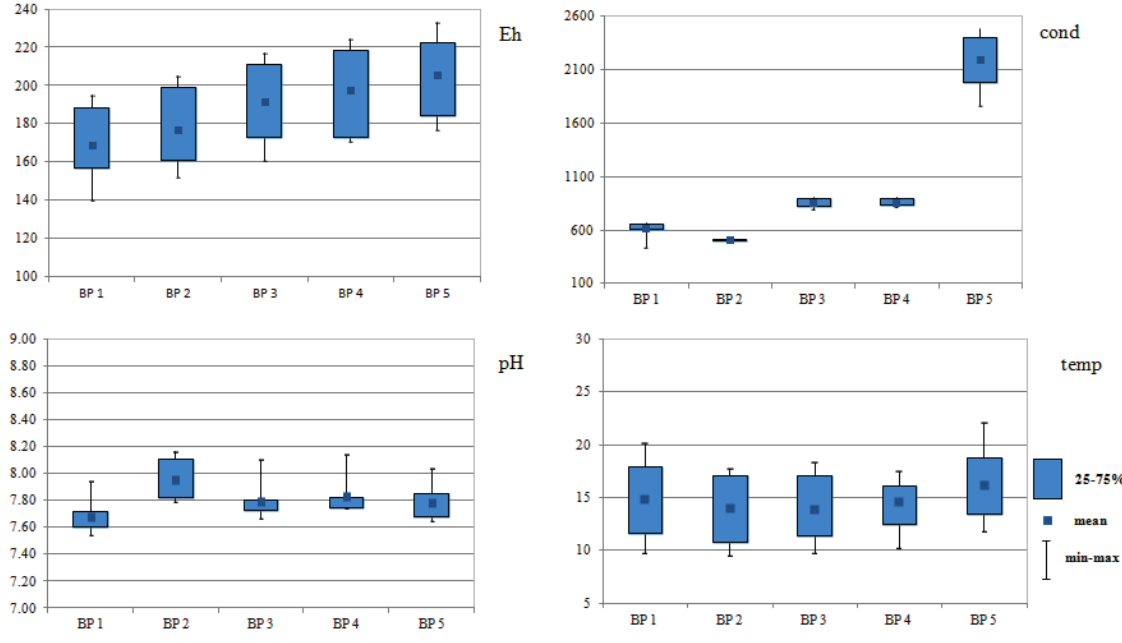
Figure 2. Box plots of pH, conductivity (µS) (cond), temperature (°C) (temp) and redox potential (Eh) data for Bia ł a Przemsza river monitoring (five sampling points BP1-BP5, samples taken from April to December 2014 Bia ł a Przemsza River water).